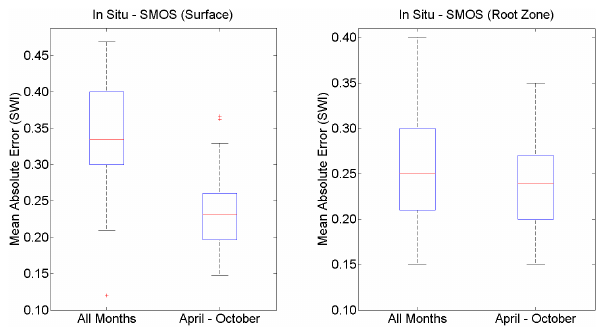
Figure 16 . Boxplots show mean bias error calculated from (left) surface SWI datasets and (right) root zone SWI datasets. MBE is calculated between Nebraska stations and SMOS data.